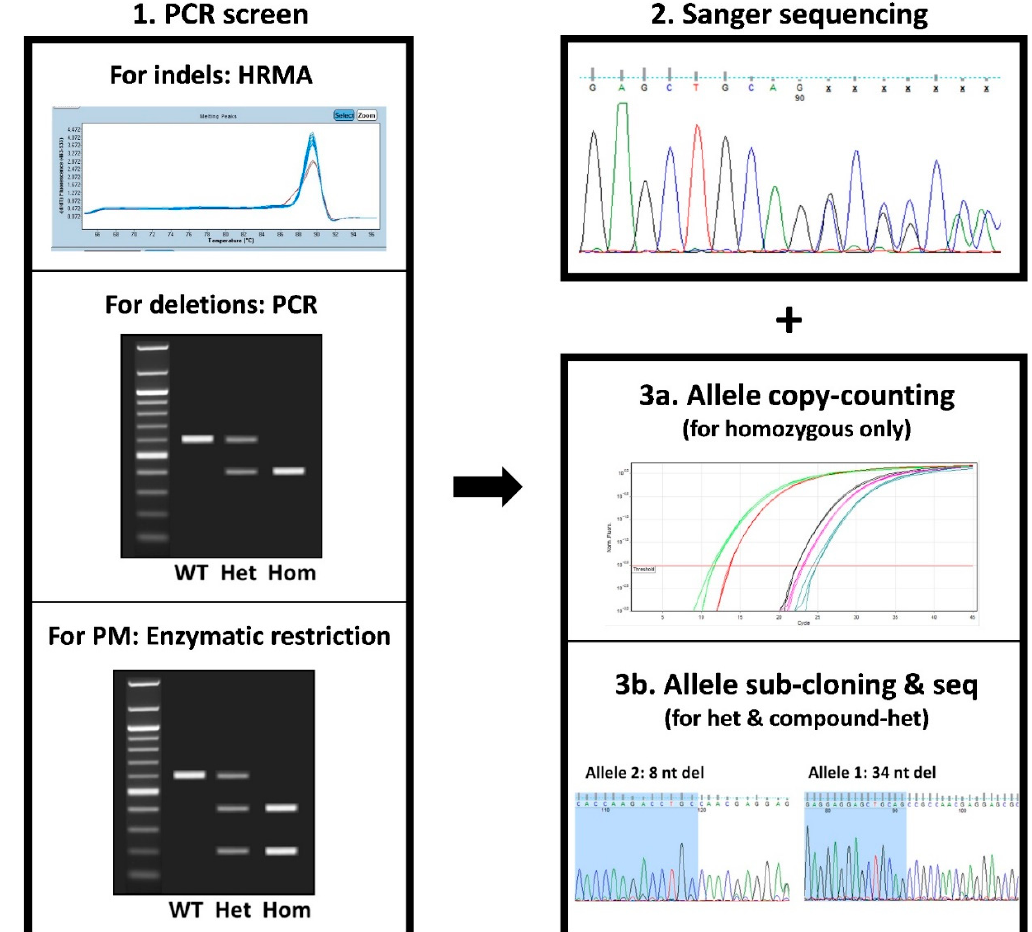
Figure 2. Screening strategies for indels, deletions, and small knock-in (KI). Screening to identify the CRISPR-edited hPSC clones harboring the desired indels, deletions, or small KI can be divided in three steps. The first step is a PCR-based screen to quickly detect clones with the on-target modification(s). For indels, the mutated clones can be identified by PCR followed by high resolution melt analysis (HRMA). To identify clones carrying a deletion, PCR with primers located at each side of the expected deleted sequence can be used. For clones carrying a small KI, if a restriction site has been added to the donor DNA template, enzymatic digestion of the PCR product that includes the targeted sequence will allow the detection of clones with on-target integration of the donor. Positive clones are then checked by Sanger sequencing to determine their exact sequence. This step is important to select clones with the desired modification(s) and to discard clones with unwanted events (i.e., in-frame events for KO projects, imperfect HDR events for a small KI project). Finally, in clones homozygous for the desired mutation, the transgene copy number is evaluated to ensure ploidy, whereas heterozygous and compound heterozygous clones are sub-cloned to determine the exact allelic sequences. PM, point mutation; WT, wild type; Het, heterozygous; Hom, homozygous; seq, sequencing; nt, nucleotides.